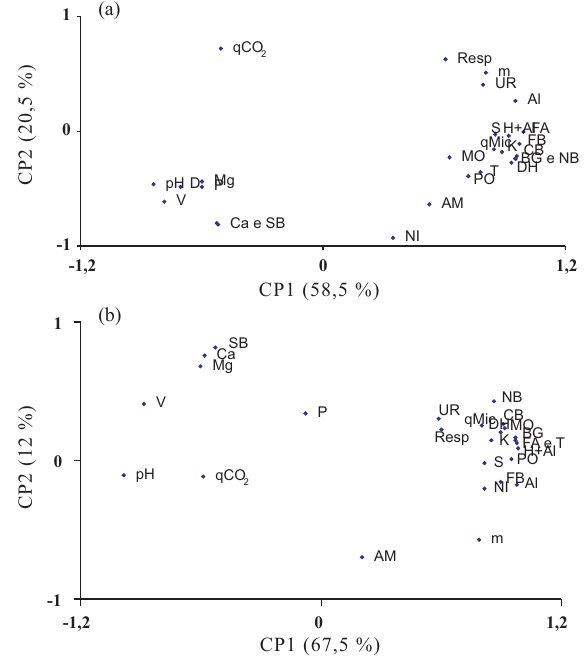
Figura 2. Dispersão dos autovalores das variáveis utilizadas na ACP em relação aos dois primeiros CPs, nas profundidades de 0 a 5 cm (a) e de 5 a 20 cm (b). CB: carbono da biomassa microbiana; NB: nitrogênio da biomassa microbiana;